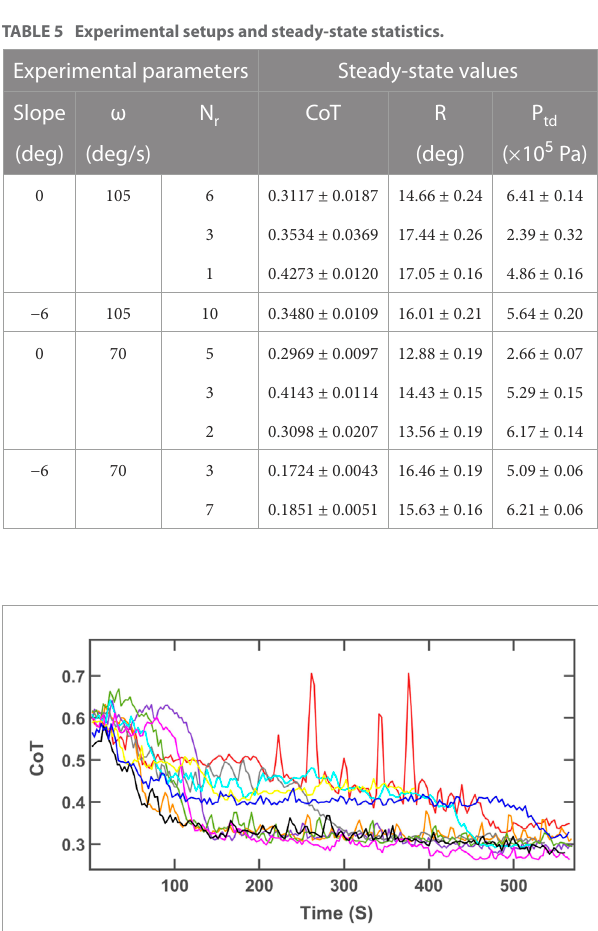
FIGURE 8 CoT of the robot trotting on a flat treadmill with the angular velocity of 105 deg/s for 10 independent